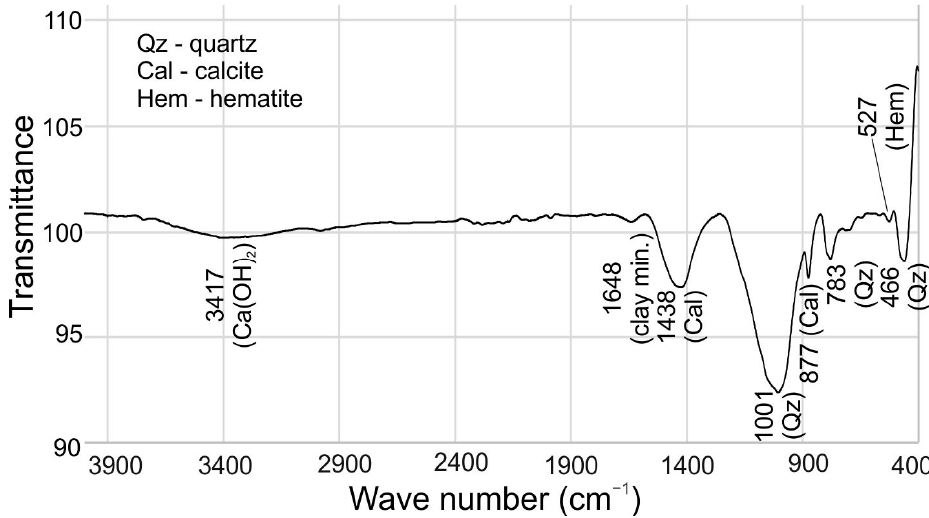
Figure 3. FTIR result of the mixed C&D waste.